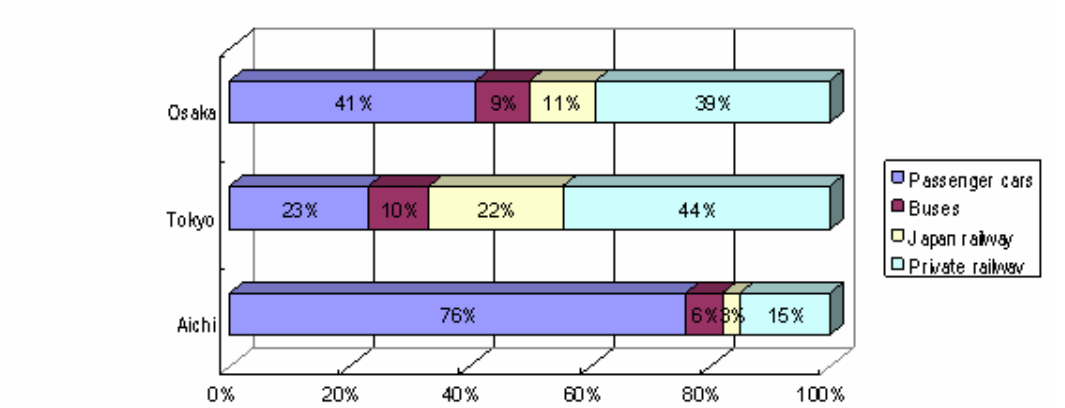
Figure 3. Shares of overland passenger transport within three major prefectures in Japan